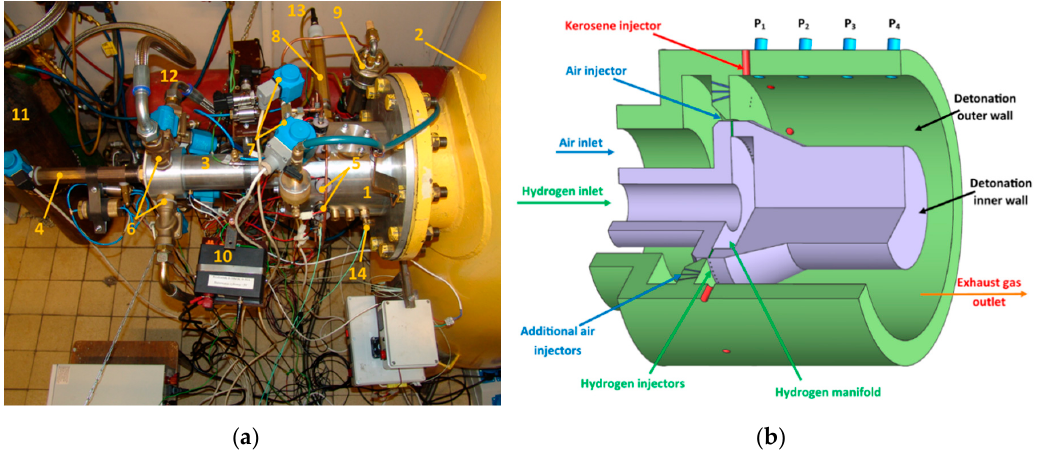
Figure 2. The experimental facility: ( a ) view of the research facility: 1 — detonation chamber, 2 — dump tank, 3 — air manifold, 4 — hydrogen feeding line, 5 — kerosene injectors 6 — air electromagnetic valves,